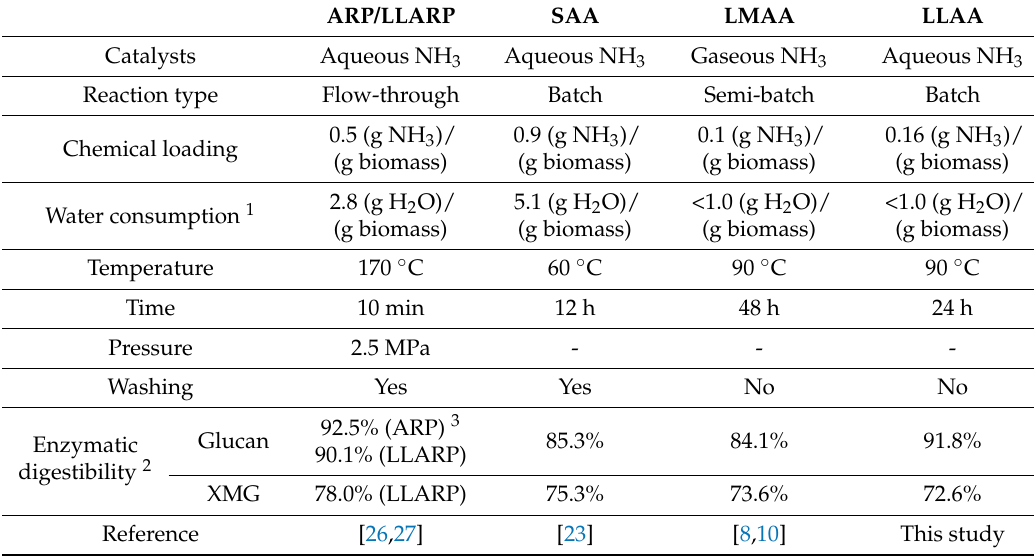
Table 5. A comparison of various ammonia pretreatment